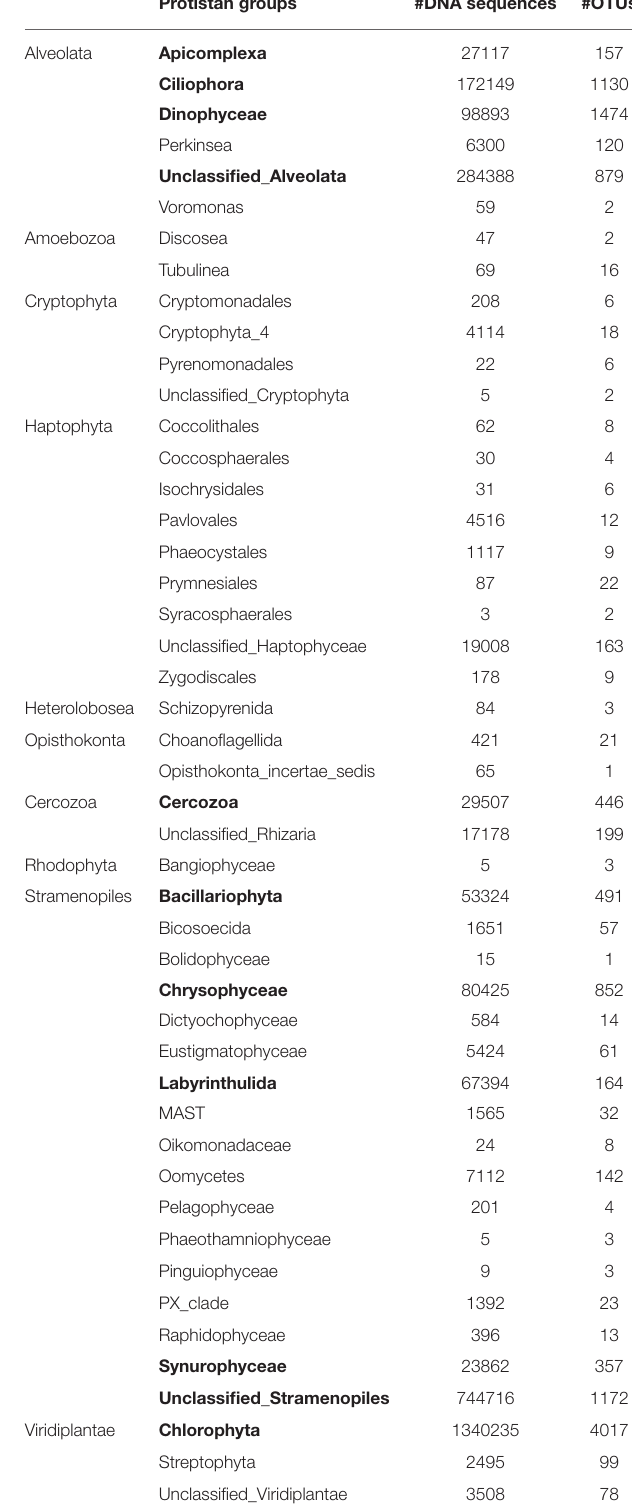
Bold characters show the 11 abundant taxonomic